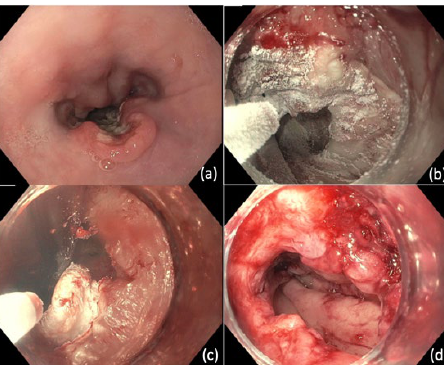
Figure 6. Palliative endoscopic cryotherapy. ( a ) Ulcerated and friable mass lesion representing squamous cell carcinoma ( b ) Application of liquid nitrogen using a spray catheter ( c ) Treatment of another area of nodularity ( d ) Site of cancer after cryotherapy .